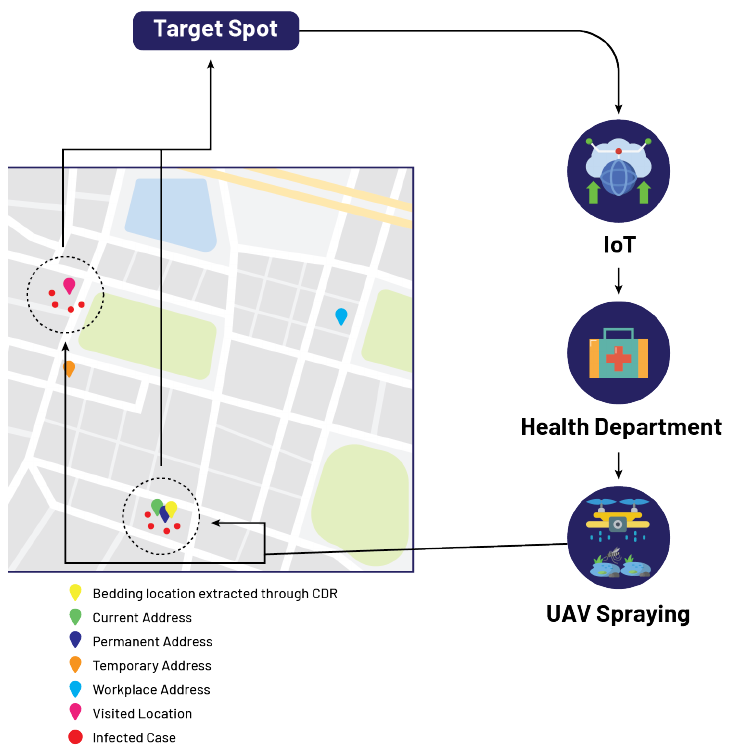
Figure 8. Localization of target spots based on proposed model.